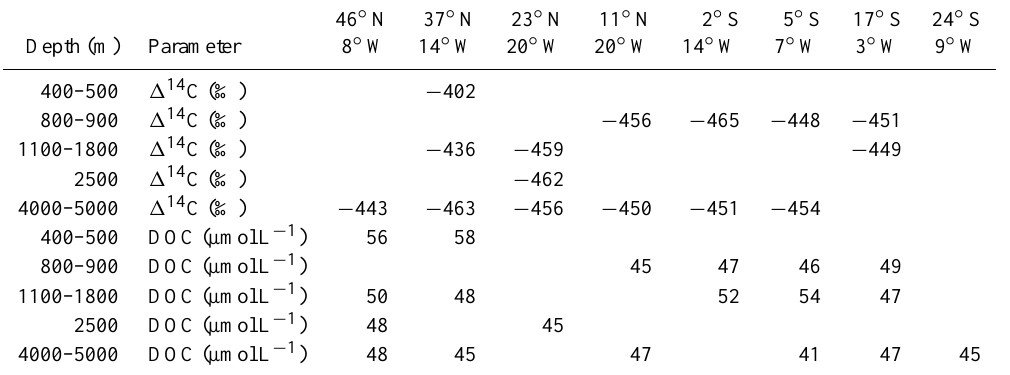
Table 1. Calculated SPE-DOM 1 14 C Cal values [‰] and bulk DOC values [µmolL − 1 ] in the deep water layers of the eastern Atlantic Ocean.